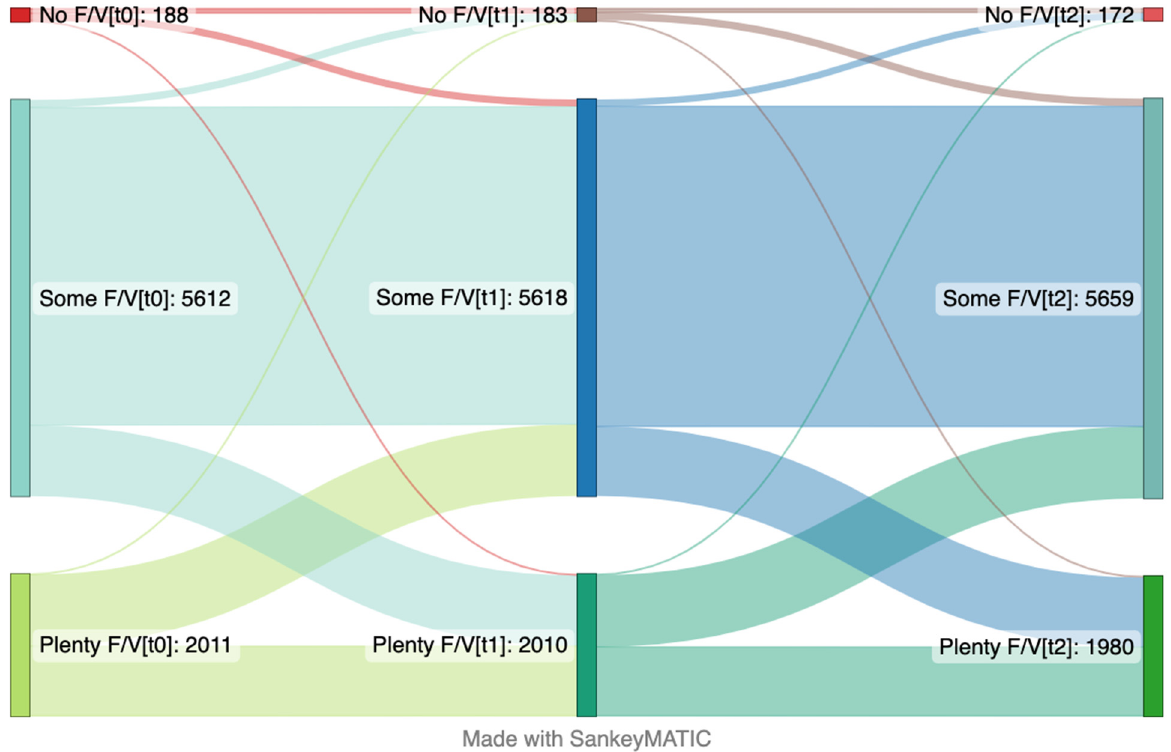
Figure 3. Sankey plot presenting changes in intake of fruit and vegetables (F/V) over time from the April 2020 (left side) to January 2021 (center) and May 2022 (right side). The number in brackets represents time points. This plot includes the participants that answered the items focusing on intake fruit and vegetables on the questionnaire at the first time point (t 0 ), second time point (t 1 ) and third time point (t 2 ) (n = 7811).